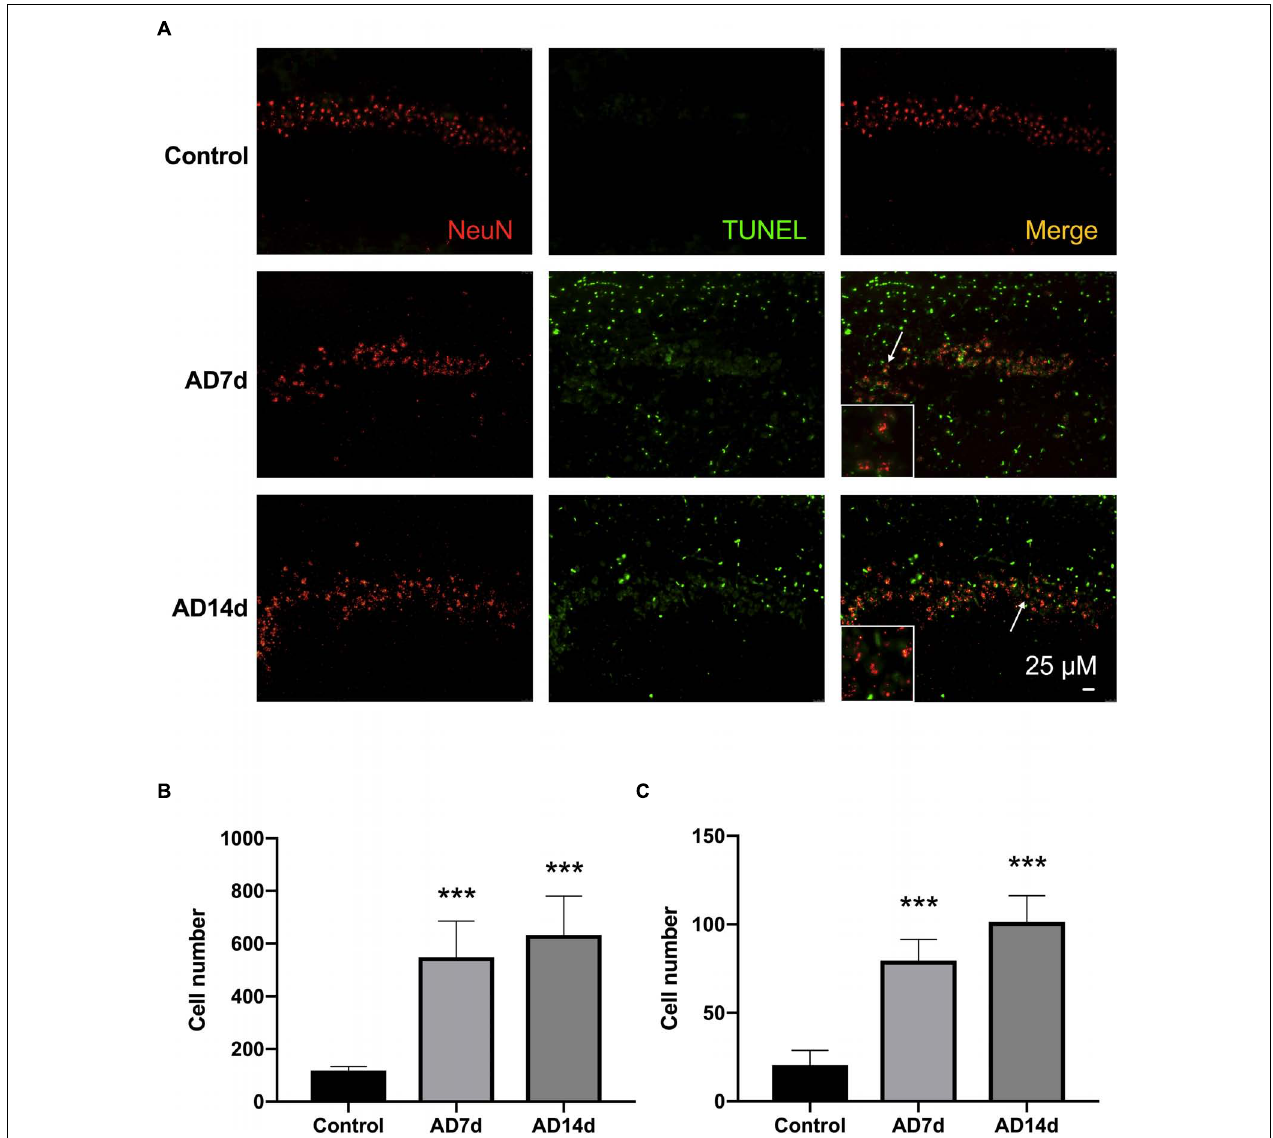
FIGURE 2 | Administration of A β 1 - 42 induces neurotoxicity. (A) Representative images of immunofluorescent histochemistry for NeuN and TUNEL in hippocampal CA1 regions of Control, AD7d, and AD14d groups. White arrows indicate TUNEL/NeuN double-stained cells. Scale bars: 25 µ m. (B) Statistical column chart of of the number of TUNEL-stained cells. (C) Statistical column chart of the number of NeuN-TUNEL neurons. A total of 18 visual fields in six hippocampal sections were counted for the TUNEL-positive or TUNEL/NeuN double-stained cells in each rat. n = 7 per group, mean ± standard deviation, ∗∗∗ P < 0.001 vs. Control